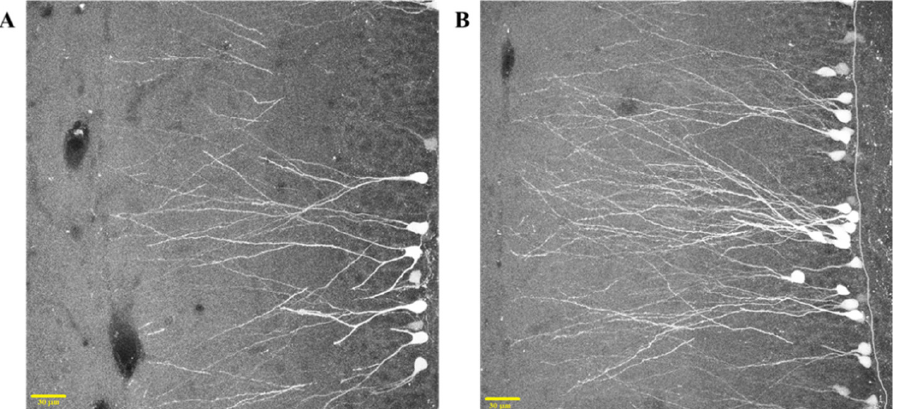
Figure 4. Retroviral labeling of 30-day-old dentate granule cells in CTRL ( A ) and RUN ( B ) rats. Morphological reconstruction of each GFP-positive cell shows retrovirally labeled newborn dentate granule cells expressing GFP throughout the entire cell. Scale bar, 30 µm.